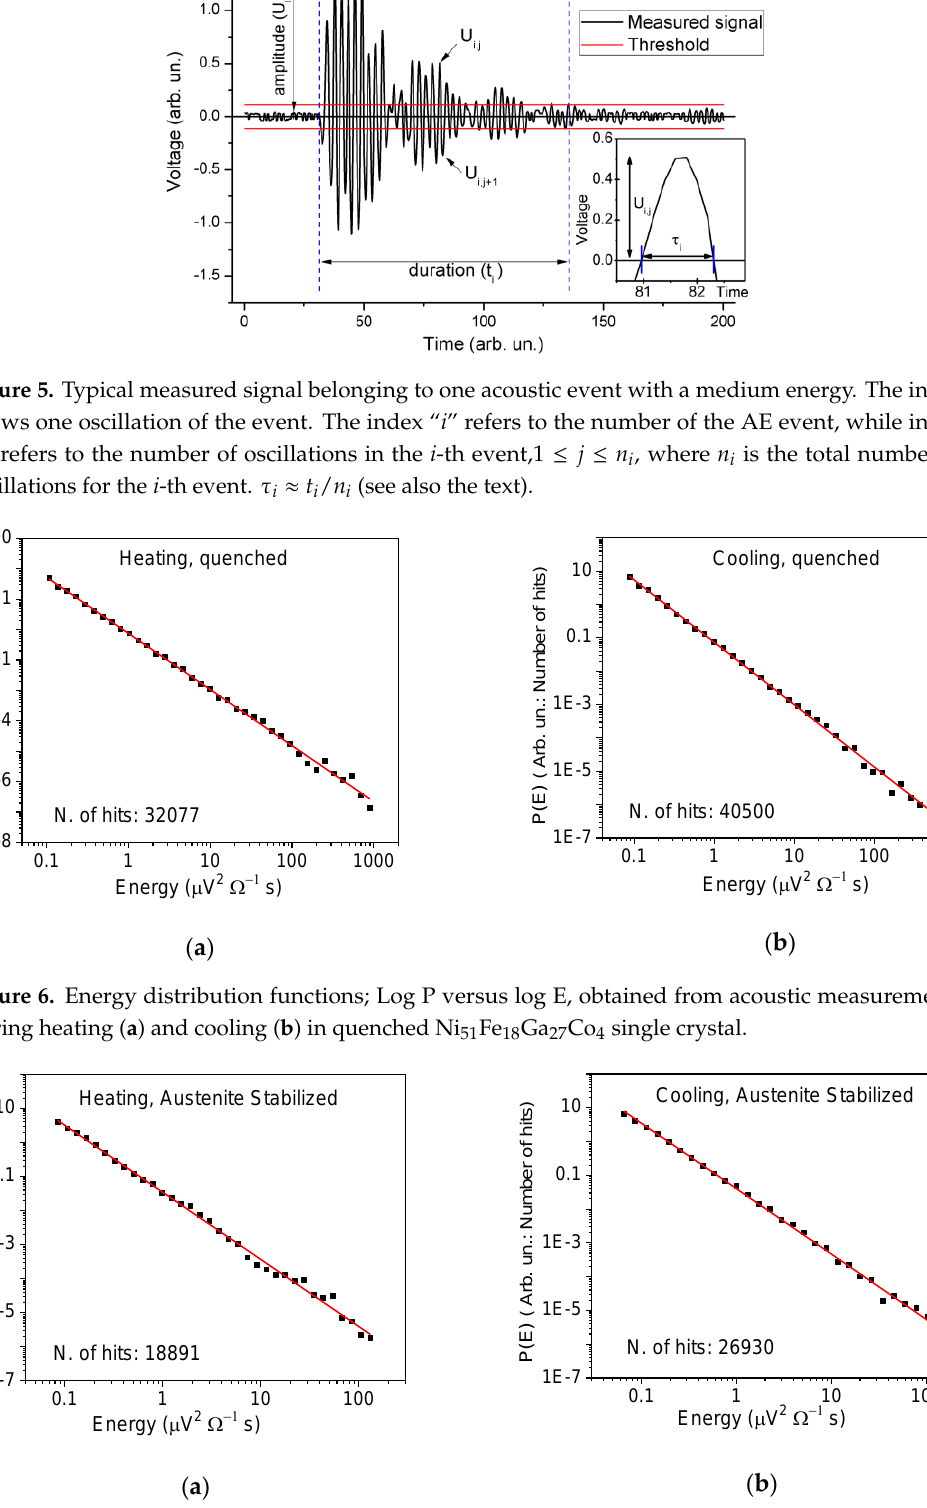
Figure 7. Energy distribution functions; Log P versus log E, obtained from acoustic measurements during heating ( a ) and cooling ( b ) in austenite stabilized Ni 51 Fe 18 Ga 27 Co 4 single crystal.